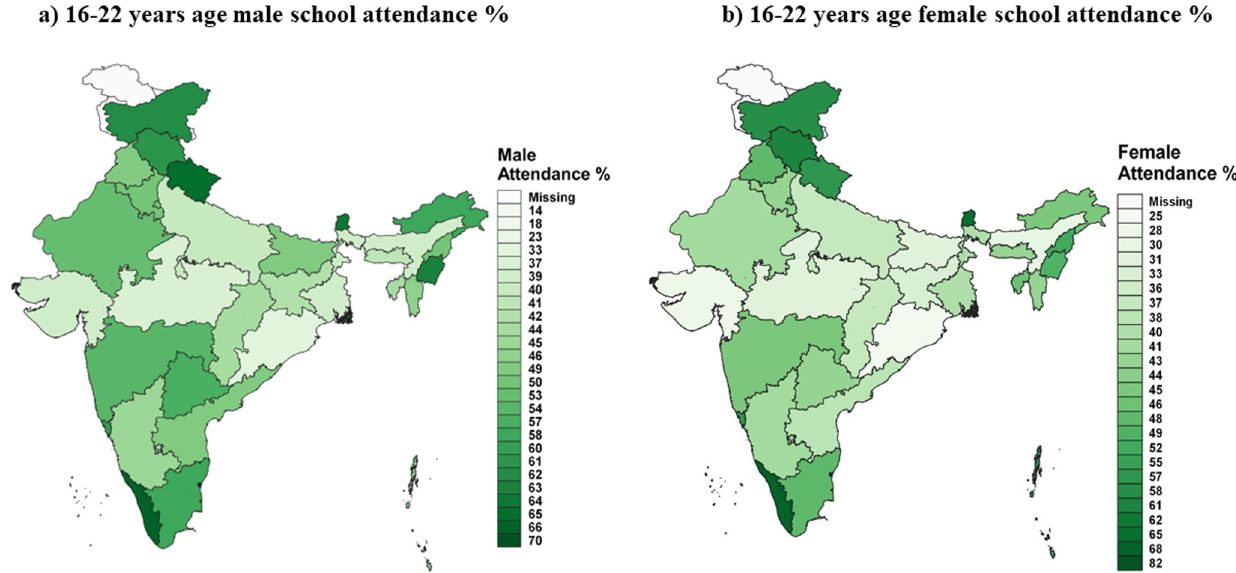
Fig. 2 Percentage of children attending school in 16 – 22 age group by gender and states of India, 2017 – 18. a 16-22 years age male school attendance % b 16-22 years age female school attendance %.